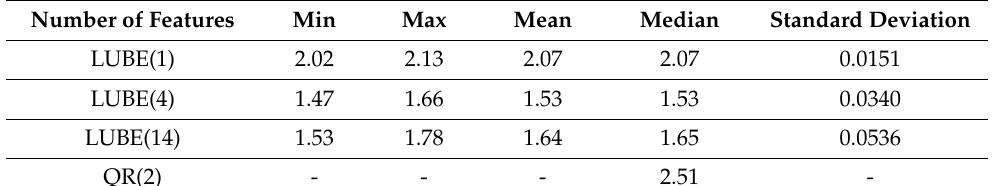
Figure 8. Number of features and 2-week average MPIW in LUBE and QR.